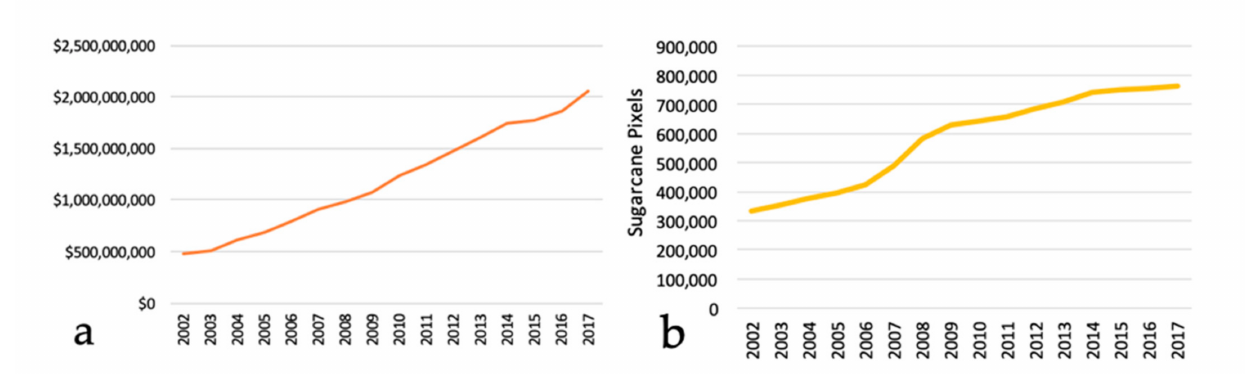
Figure 10. Yearly growth trends for GDP (inflation adjusted) and sugarcane: ( a ) yearly GDP for S ã o Paulo in Brazilian Real (R); ( b ) count of sugarcane pixels detected by year.